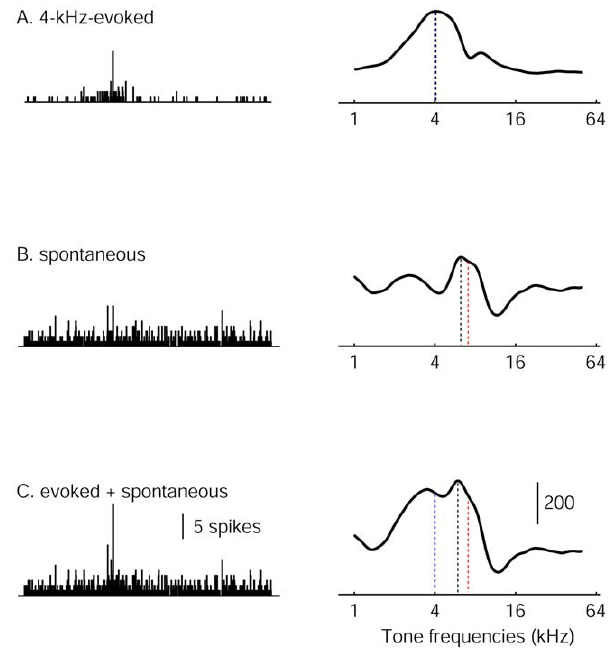
Figure 2. Neuronal population activity and derived log- likelihood functions. Left panels show population activity of the model 7-kHz-over-represented AI, and the right panels show stimulus log-likelihood functions. ( a ) Response of the model to a 4-kHz tone pip ( b ) Elevated baseline activity in the absence of a stimulus ( c ) Summed spontaneous and 4-kHz-evoked activity). Each bar in the left panels represents the firing rate of a model neuron. The neurons are arranged by characteristic frequency, with low frequency-tuned neurons on the left and high frequency-tuned neurons on the right. Blue dotted lines in the right panels show the input frequency, red dotted lines show the over-represented frequency, and the black dotted lines mark the peaks of the log-likelihood functions.